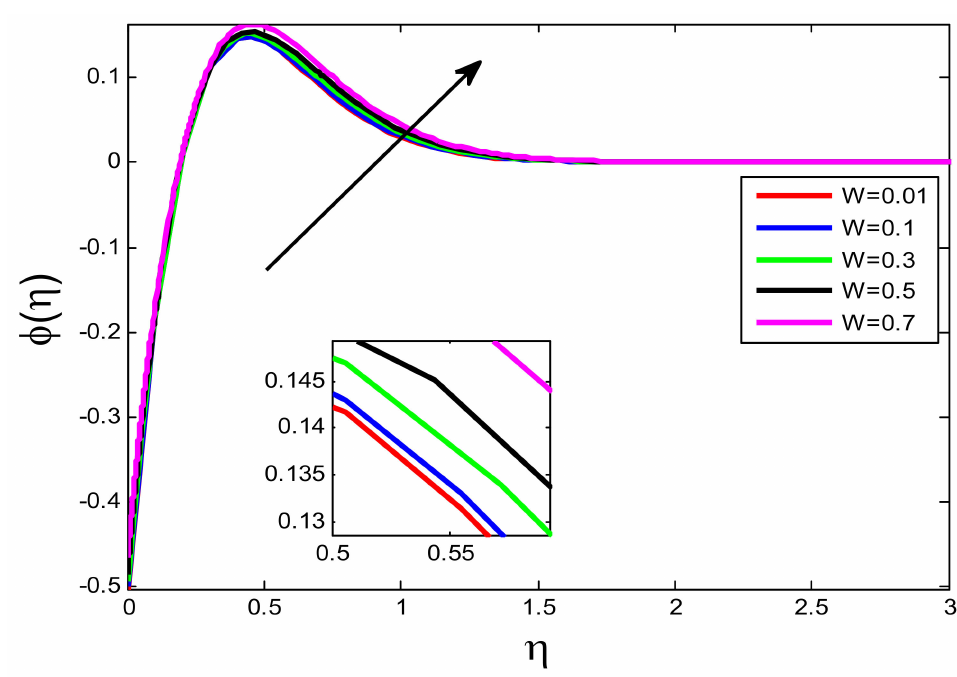
Figure 8. Influence of W on f (cid:48) ( η ) .